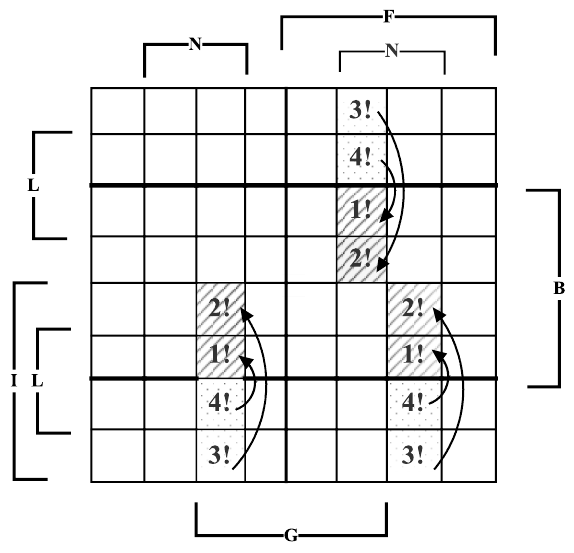
Fig. 9. Transitions similar to those in Fig. 8, but now w. r. t. the